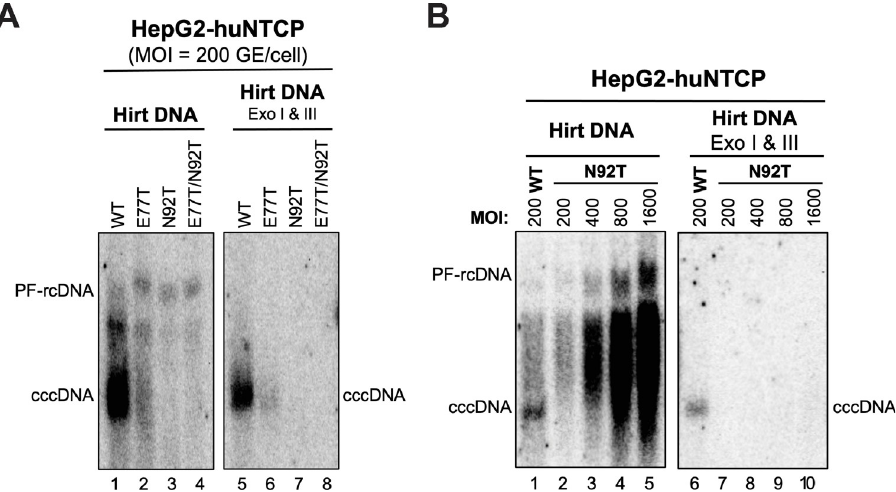
Fig 5. Effects of introducing N-glycosylation sequons on de novo HBV infection. HBV inocula were prepared from HBV replicon transfected Huh7 cells. (A) Infection of WT, E77T, N92T, and E77T/N92T mutant virus (MOI = 200 GE/cell) in HepG2-huNTCP cells. PF-DNA was extracted from infected cells at 4 dpi by the Hirt extraction method and analyzed by Southern blot analysis, without (lanes 1–4) or with pretreatment by Exo I & III (lanes 5–8). (B) Infection of N92T mutant virus with increased dosage (MOI = 200, 400, 800, or 1600 GE/cell) in HepG2-huNTCP cells. PF-DNA was extracted from infected cells at 4 dpi and analyzed by Southern blot analysis as described above. PF- rcDNA, protein-free rcDNA; cccDNA, covalently closed circular